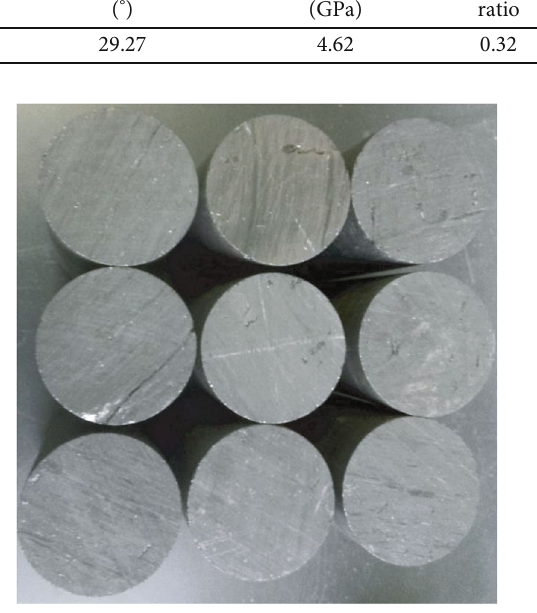
Figure 1: Prepared coal